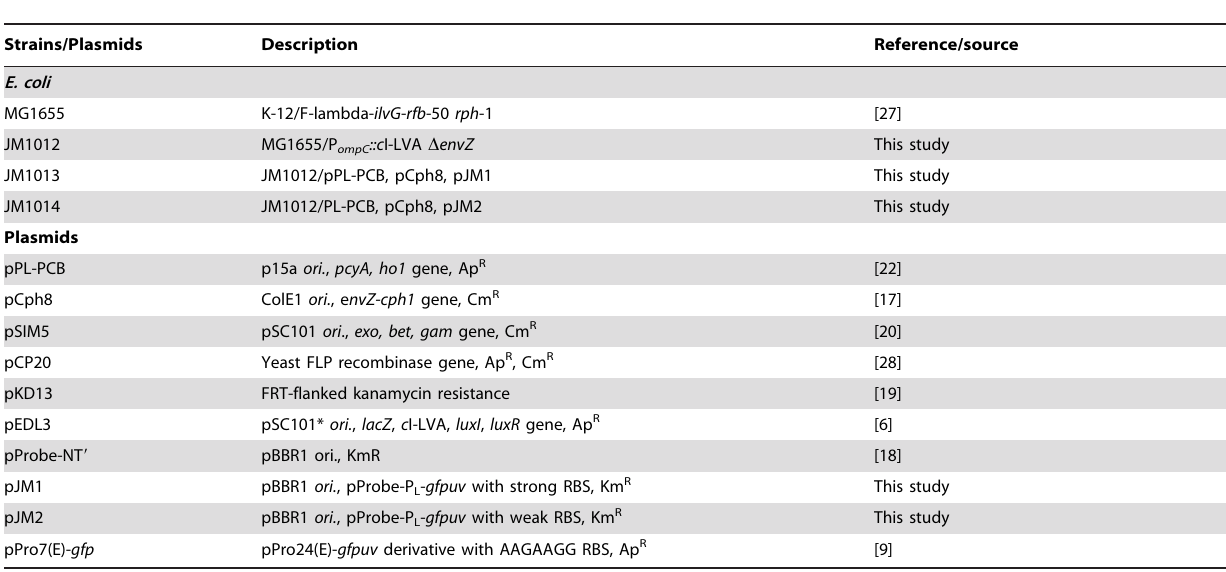
Table 1. Strains and plasmids used in this